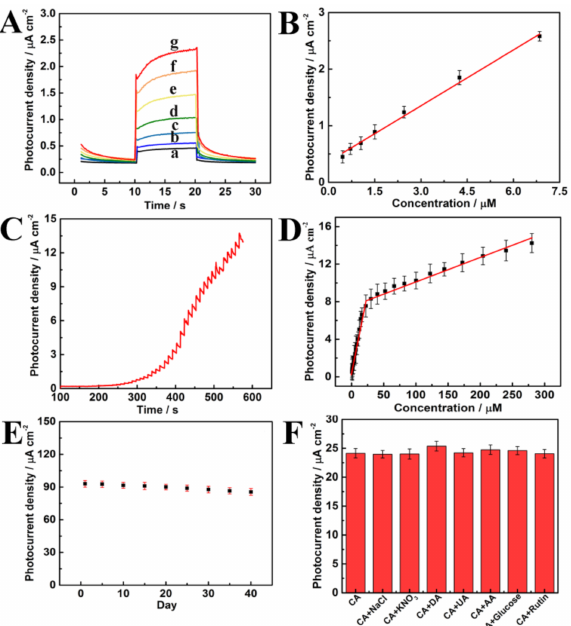
Figure 5. ( A ) The i-t performance of Au / NGQD electrodes in di ff erent concentrations of CA: ( a – g ) 0.46, 0.71, 1.05, 1.50, 2.45, 4.25, and 6.85 µ M, respectively. ( B ) Plot of photocurrent density vs. CA concentration. ( C ) Transient photocurrent density vs. time plotted for the Au / NGQD electrodes in BR bu ff er solutions (pH 3.0) containing di ff erent concentrations of CA, ranging from 0.11 to 30.25 µ M and